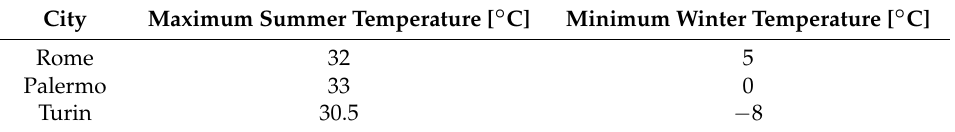
Table 3. Maximum summer and minimum winter external